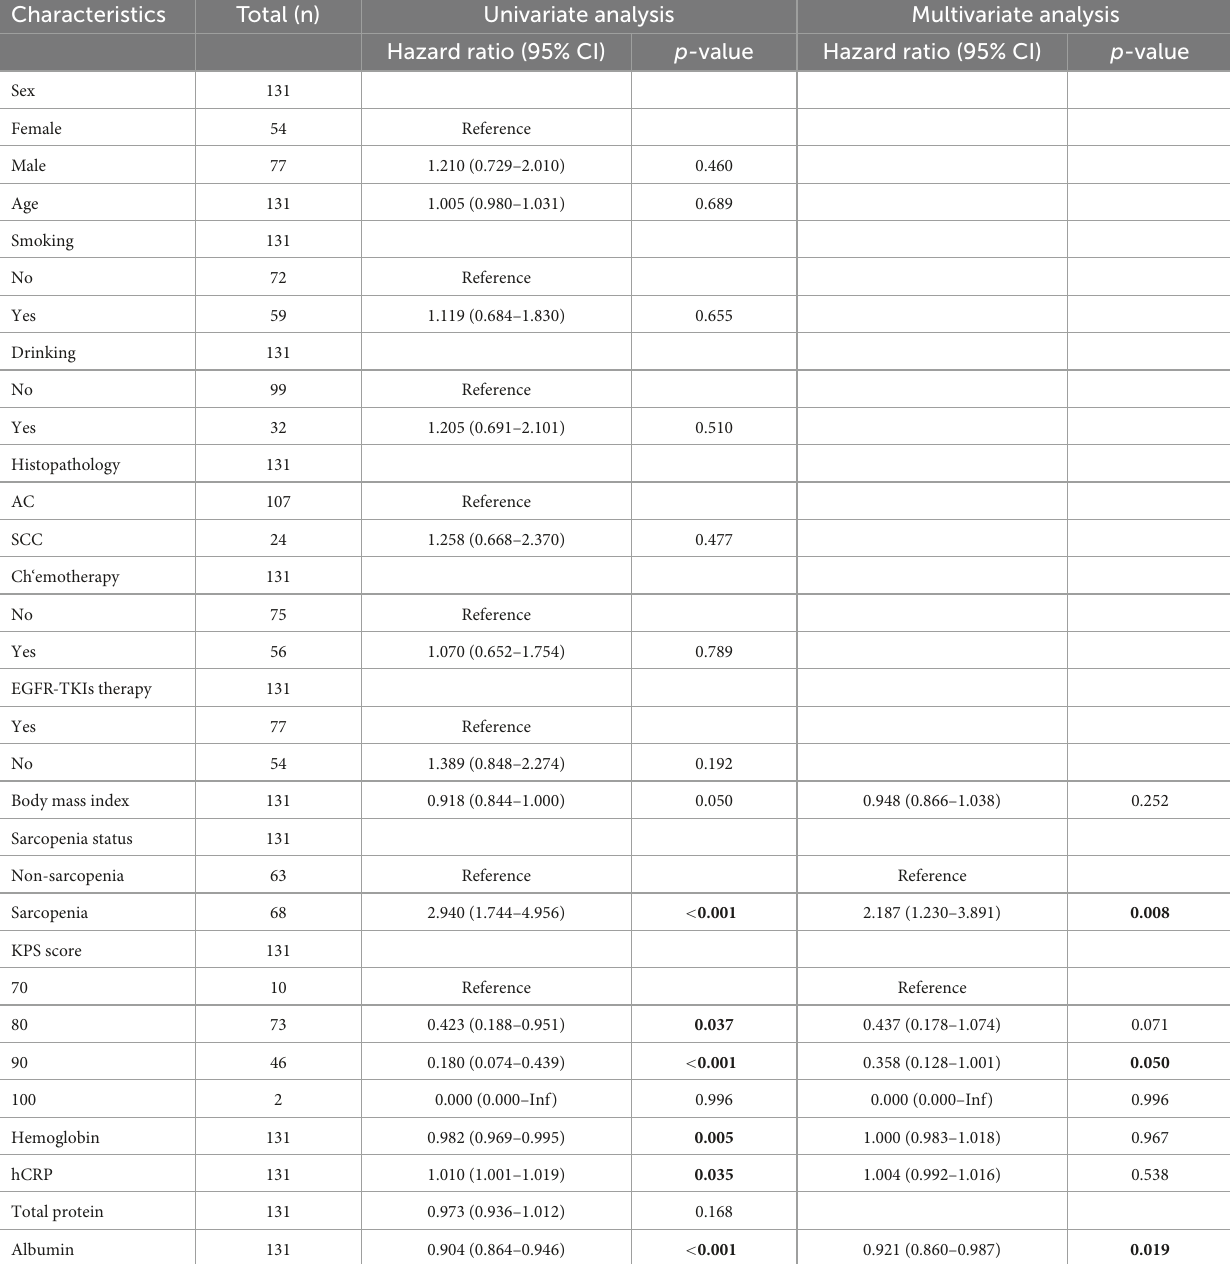
TABLE 2 Results of Cox regression analysis for overall survival for all